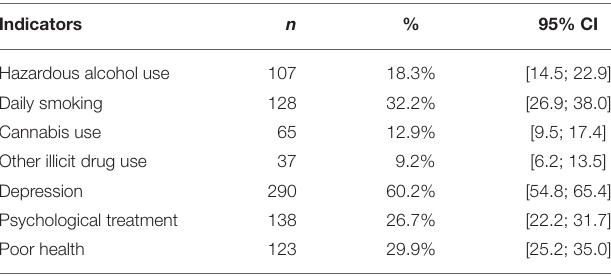
TABLE 1 | Weighted prevalence proportions of class-defining variables ( n =